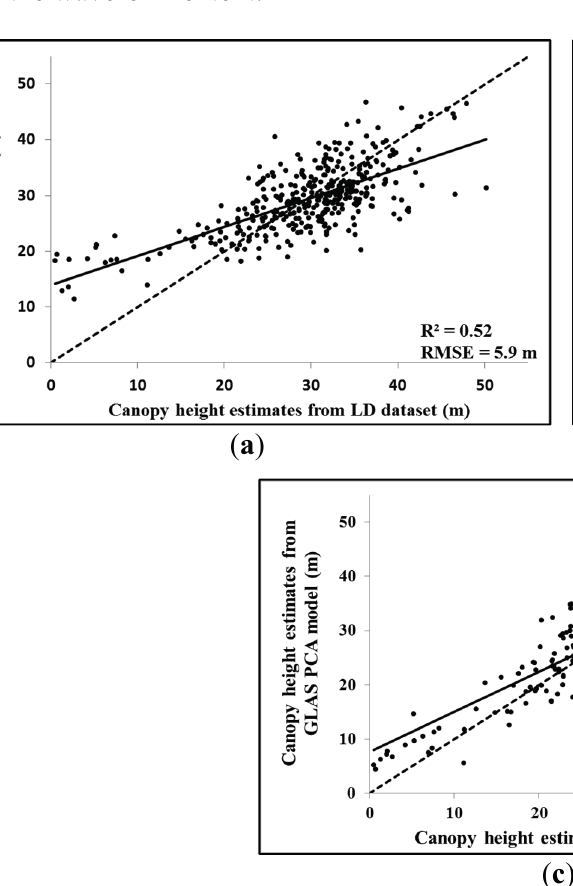
Figure 7. Comparison between canopy height estimates using the PCA regression models and those estimated from low-density airborne LiDAR data (LD) ( a ) using the first 13 PCs, ( b ) using the first 13 PCs with the waveform extent, and ( c ) using the first three PCs with the waveform